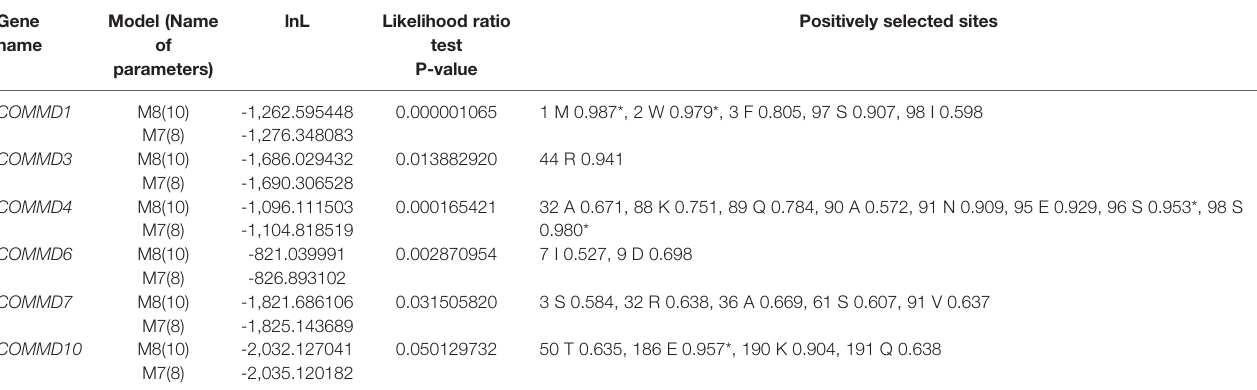
TABLE 2 | Likelihood values and parameter estimates of computing position selection site by site model for the COMMD family